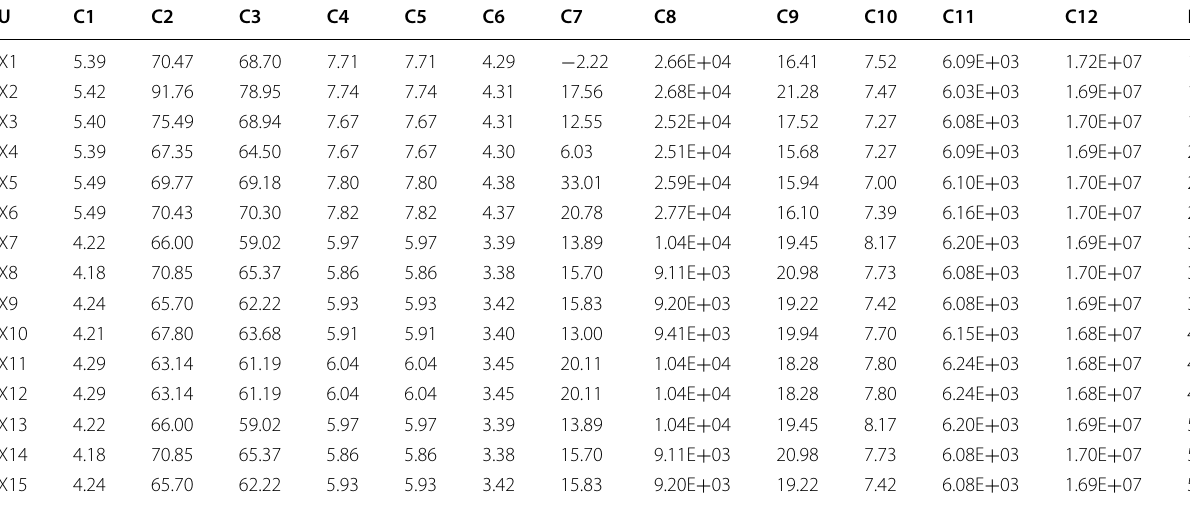
Table 3 The initial decision table for the fault features is